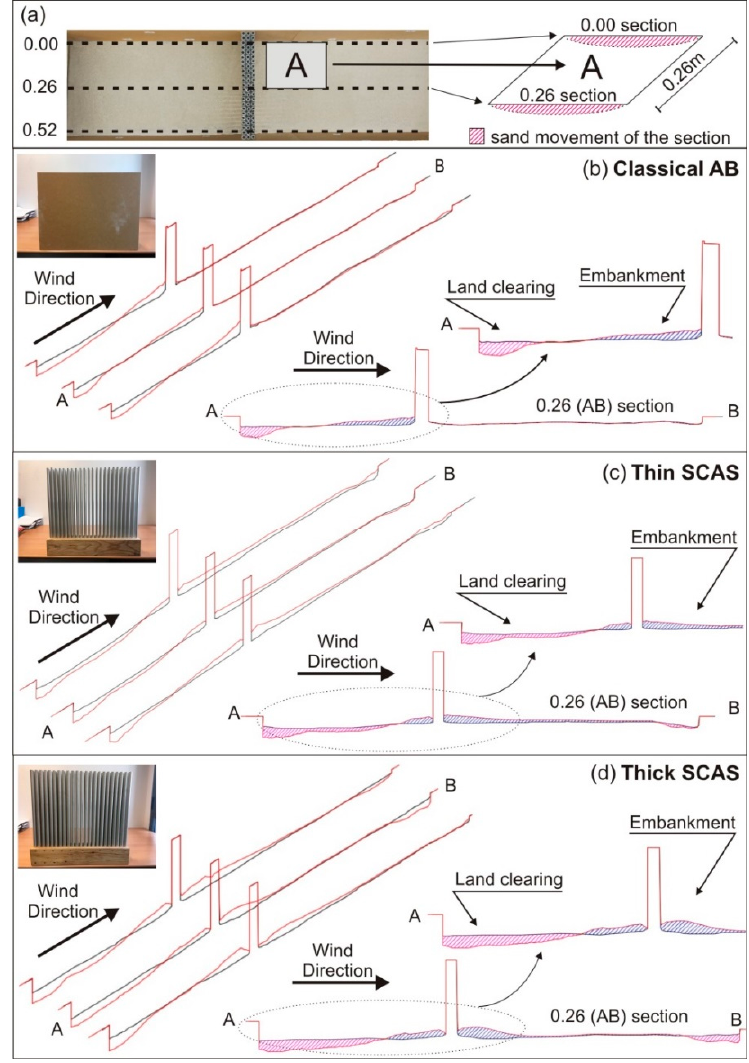
Figure 7. ( a ) Longitudinal sections used to evaluate the clearing or embankment of sand on both sides of each AB; ( b )–( d ) For each AB: the three longitudinal sections considered shown in perspective and the 0.26 profile image with an enlargement of the area close to the AB.